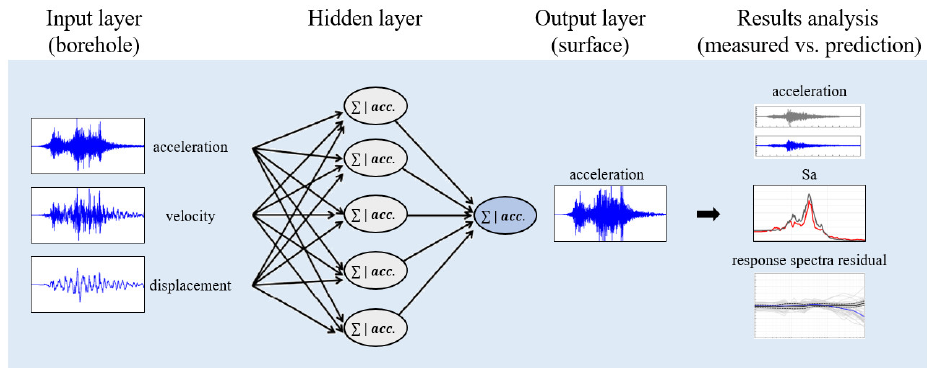
Figure 3. Schematic of MLP process for the seismic ground response analysis.